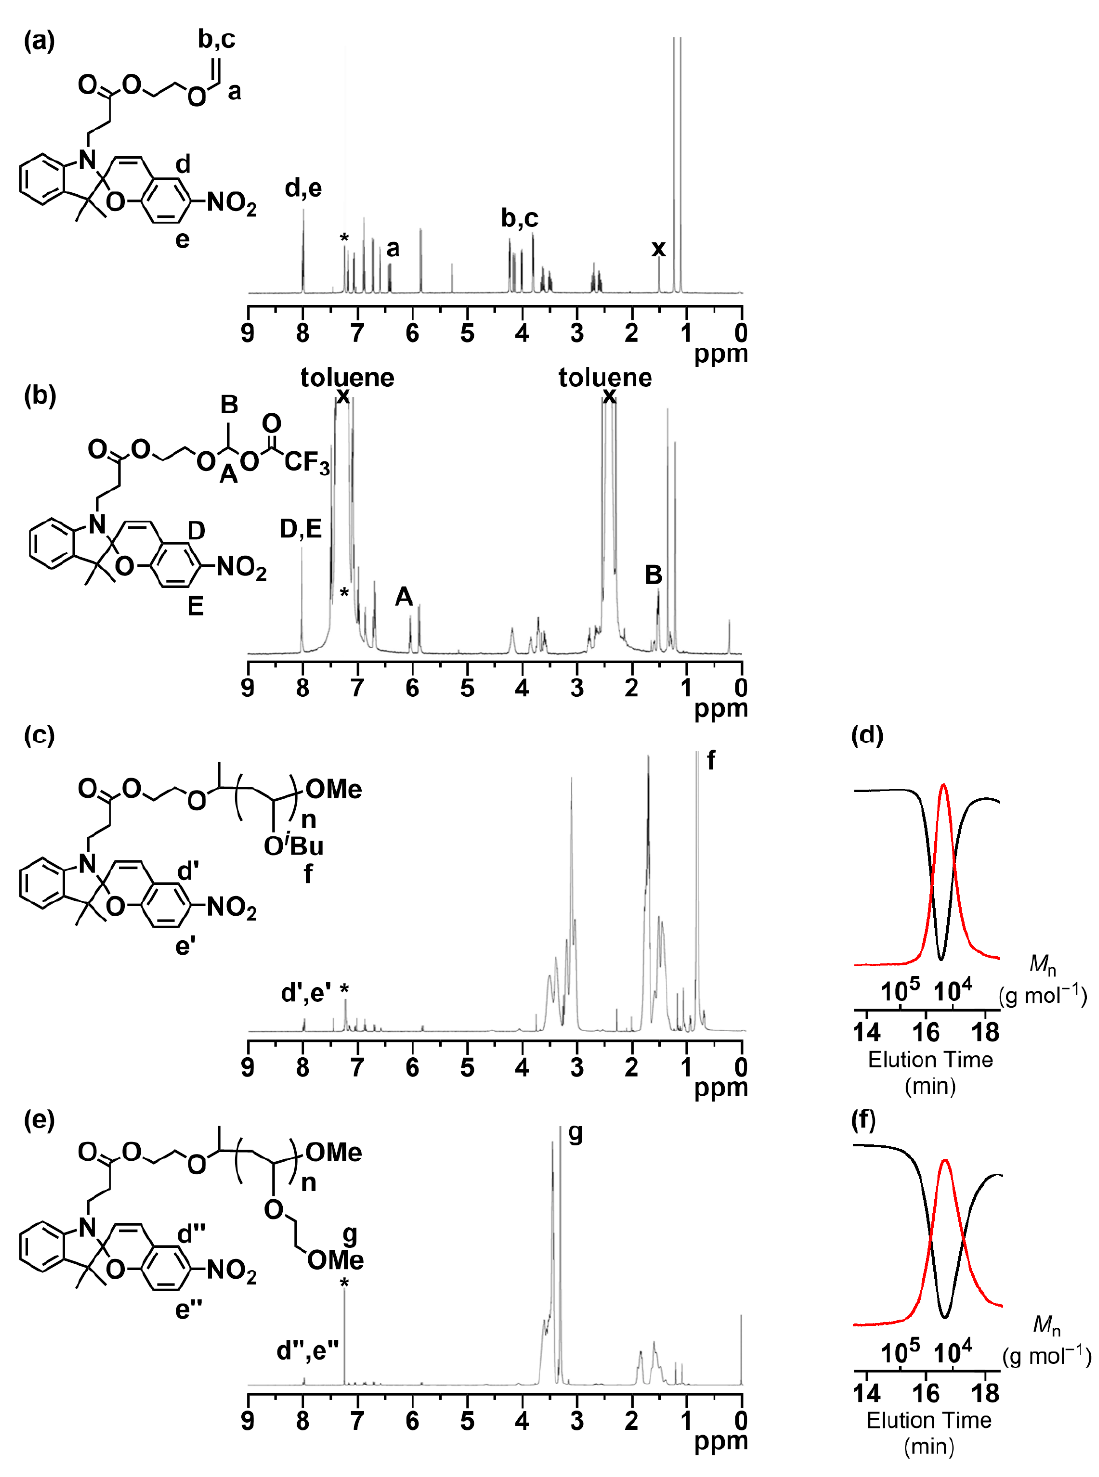
Figure 2. 1 H NMR spectra of ( a ) SPVE, ( b ) SPVE-TFA, ( c ) SP-PIBVE, and ( e ) SP-PMOVE in CDCl 3 (asterisk and x indicate remaining CHCl 3 and other solvents, respectively). RI (red line) and UV (254 nm, black line) detected SEC curves of ( d ) SP-PIBVE, and ( f ) SP-PMOVE using THF as the eluent.